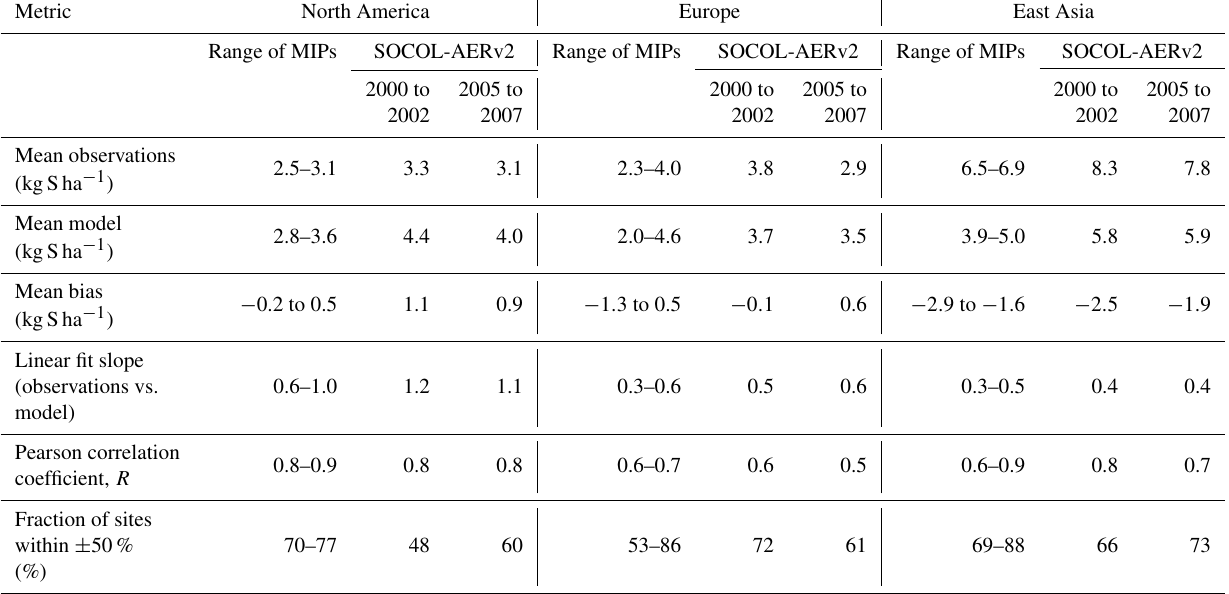
Table 3. Metrics comparing the agreement of simulated sulfate wet deposition with the WMO database, separated by measurement region. Results from SOCOL-AERv2 from two time periods are compared with the range of values from past model intercomparison projects (MIP), including Photocomp (Dentener et al., 2006b), HTAP I (Vet et al., 2014), ACCMIP (Lamarque et al., 2013), and HTAP II (Tan et al., 2018). Note that the observational and simulation time periods covered by the other model intercomparison projects differ from SOCOL-AER in this study (see Table S1 in the Supplement). The metrics are calculated in linear space to conform with past MIPs: linear fit slopes differ from the power regression in Fig. 6 and fractions of sites where the model is within ± 50% of observations differ from the fraction within a factor of 2 listed in Fig.